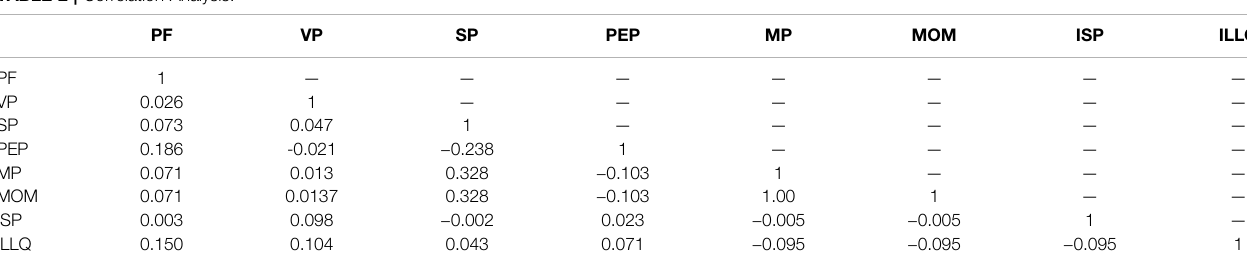
TABLE 2 | Correlation